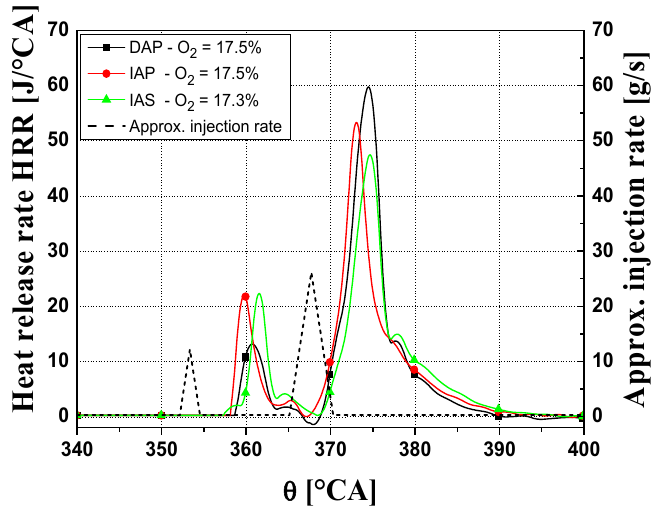
Figure 7. HRR traces featuring similar EGR rates, at 1500 × 2, for the three injector typologies under investigation.